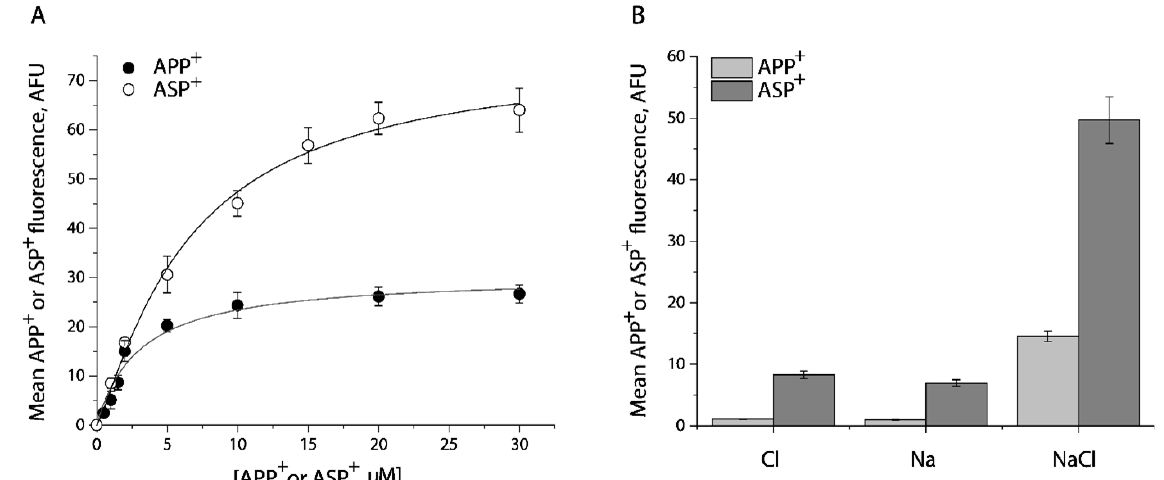
Figure 1. Kinetic analysis and ion requirements for APP + or ASP + uptake by SERT. ( A ) Kinetic analysis for APP + or ASP + uptake by SERT. The cells stably expressing WT-SERT were incubated with APP + or ASP + over a range of concentrations, as indicated, in the absence or presence of 10 μM fluoxetine at 22 °C for 5 min. After washing to remove excess APP + or ASP + , the accumulated fluorescence within the cells ( n ≥ 30) were counted and normalized to the cell areas, as described under “Materials and Methods”. Nonspecific transport for APP + or ASP + was measured in the presence of 10 μM fluoxetine and was subtracted to give APP + or ASP + transport, respectively. The graph shows a representative experiment with APP + or ASP + influx expressed as mean fluorescence (AFU). The experiment was repeated twice with similar results. The K m value for APP + or ASP + was 2.63 ± 0.06 μM or 8.52 ± 0.15 μM, and V max for APP + or ASP + was 30.5 ± 1.4 AFU, or 75.8 ± 5.3 AFU, respectively. These K m and V max values represent mean ± SEM of three experiments. ( B ) Ion- dependence of APP + or ASP + uptake. APP + or ASP + uptake was measured by incubating the cells stably expressing WT- SERT with APP + at 2 μM or ASP + at 10 μM in HEPES buffer containing 150 mM NMDGCl, sodium isethionate, or NaCl, respectively. Error bars represent SEM of three experiments.